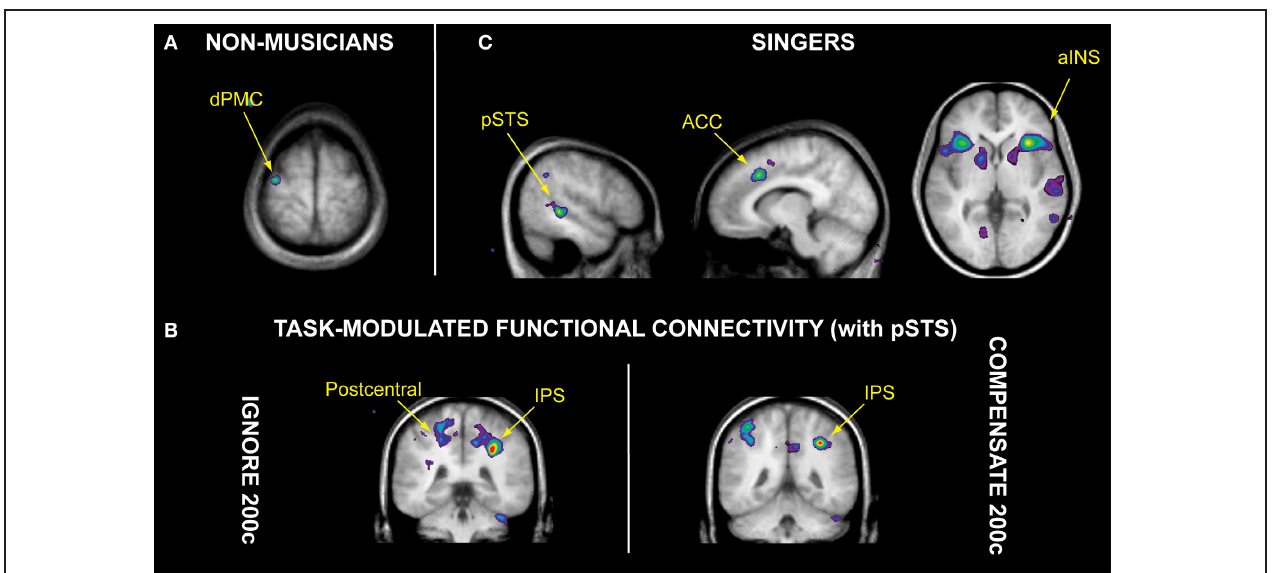
(C) Analyses of task-modulated functional connectivity revealed that relative to singing with normal auditory feedback, the 200-cent pitch shift specifically enhanced functional connectivity between right pSTS and intraparietal sulcus (IPS) during both the “ignore 200c” and “compensate 200c” tasks, as well as the postcentral gyrus (containing somatosensory cortex) during the “ignore 200c” task. Data from Zarate and colleagues (2008,